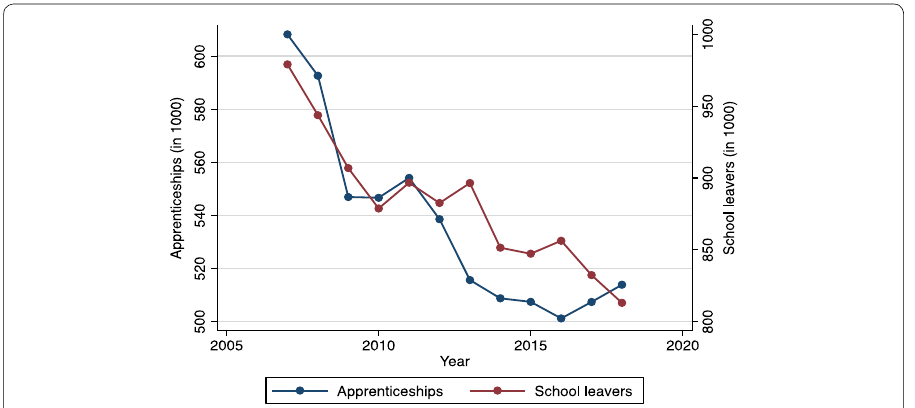
Fig. 4 Number of firm-sponsored apprenticeship contracts and school leavers (2007–2018). Sources: Vocational Training Statistics of the statistical offices of the federal and state governments; Federal